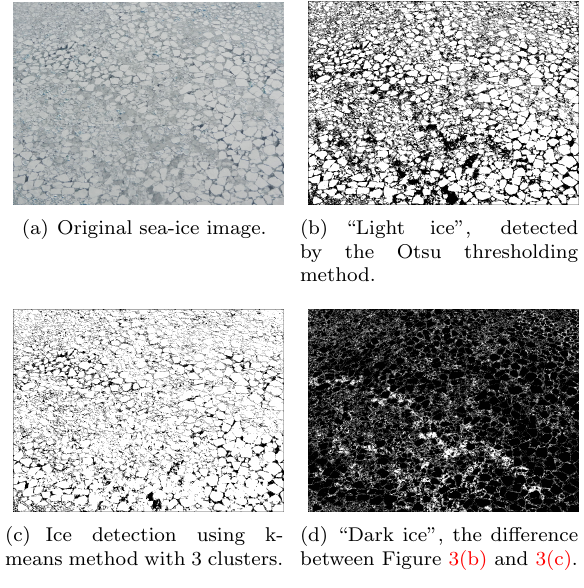
Figure 3: Ice pixel detection.